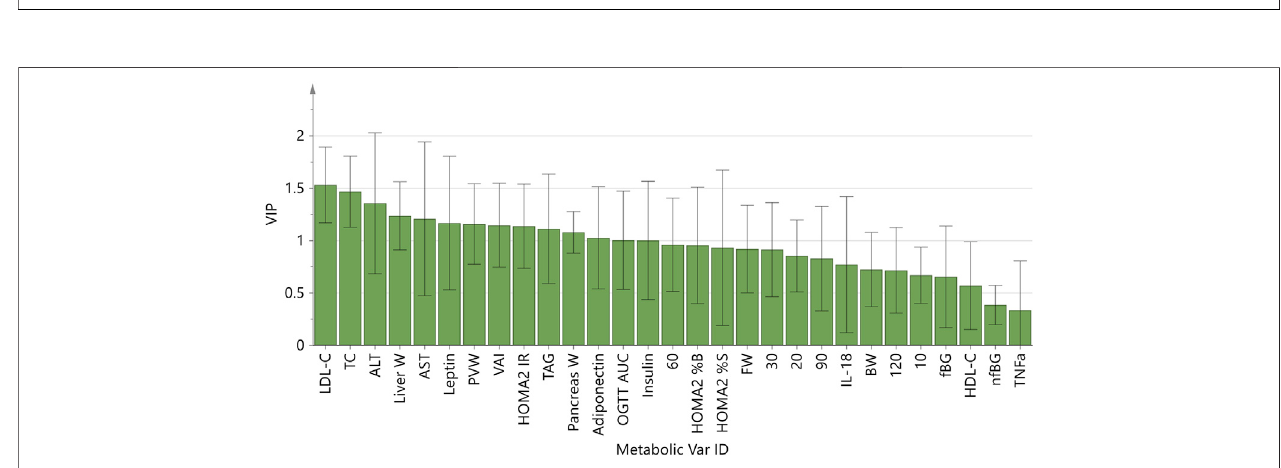
FIGURE 3 | OPLS-DA model Variable Importance for Projection (VIP) scores